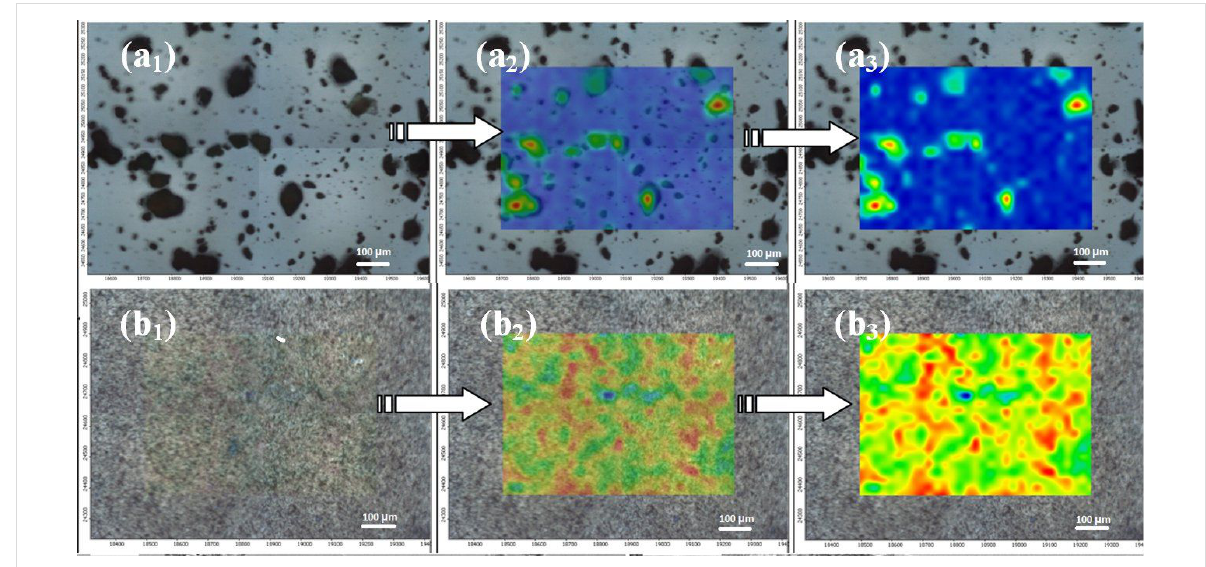
Figure 2: Full spectral intensity based on visible images and infrared maps of PLA-CS-Fe 3 O 4 @EUG drop cast (a) and PLA-CS-Fe 3 O 4 @EUG MAPLE thin coatings (b) overlain on the surface.